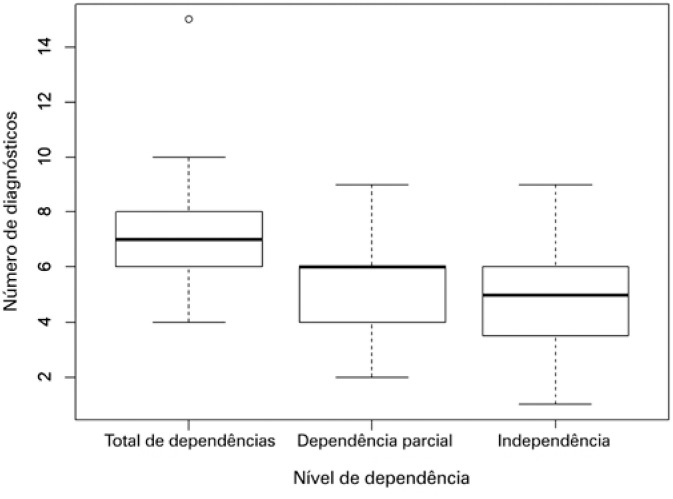
Relações entre o número de diagnósticos de enfermagem identificados por paciente e nível de dependência